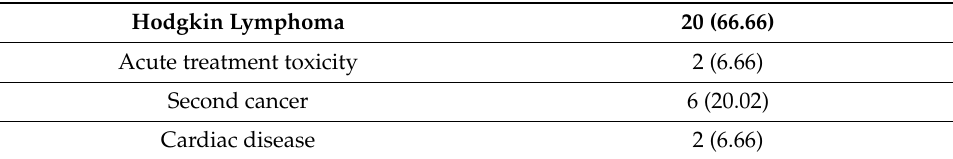
Table 3. Causes of